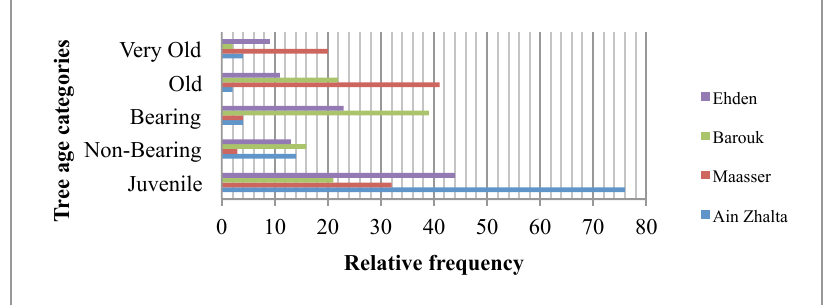
Figure 3. Relative frequency (%) of the different tree age categories in 400 m 2